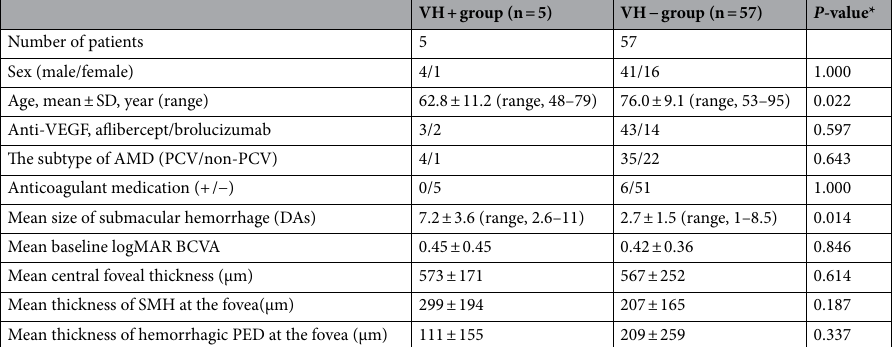
Table 2. Comparison between VH + group and VH − group. SMH submacular hemorrhage, AMD age-related macular degeneration, SD standard deviation, VEGF vascular endothelial growth factor, PCV polypoidal choroidal vasculopathy, DAs disc areas, BCVA best-corrected visual acuity, PED pigment epithelial detachment. * P -value calculated using Man-Whitney U test and the Fisher’s exact test.